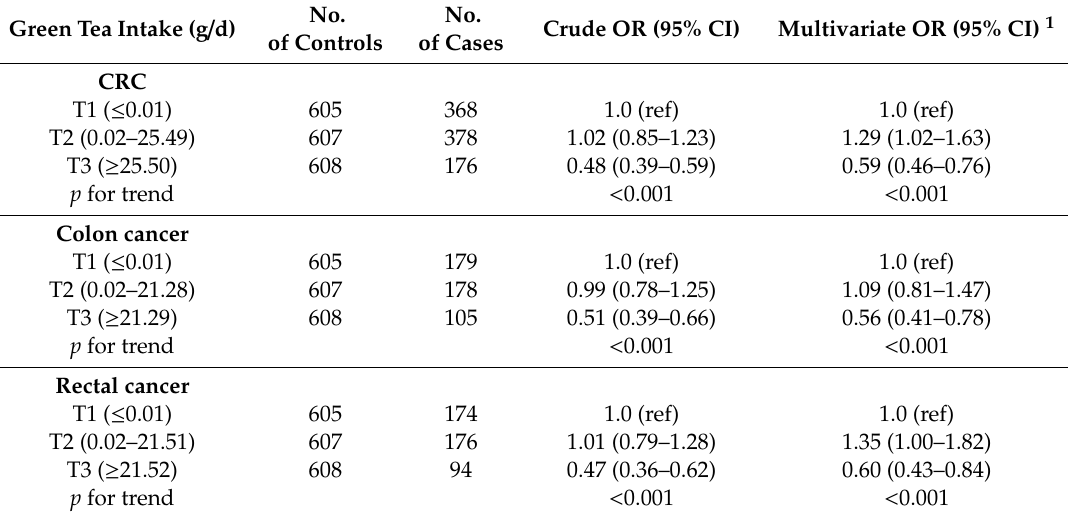
Table 2. Associations between green tea intake and CRC risk by anatomical site. Green Tea Intake (g /